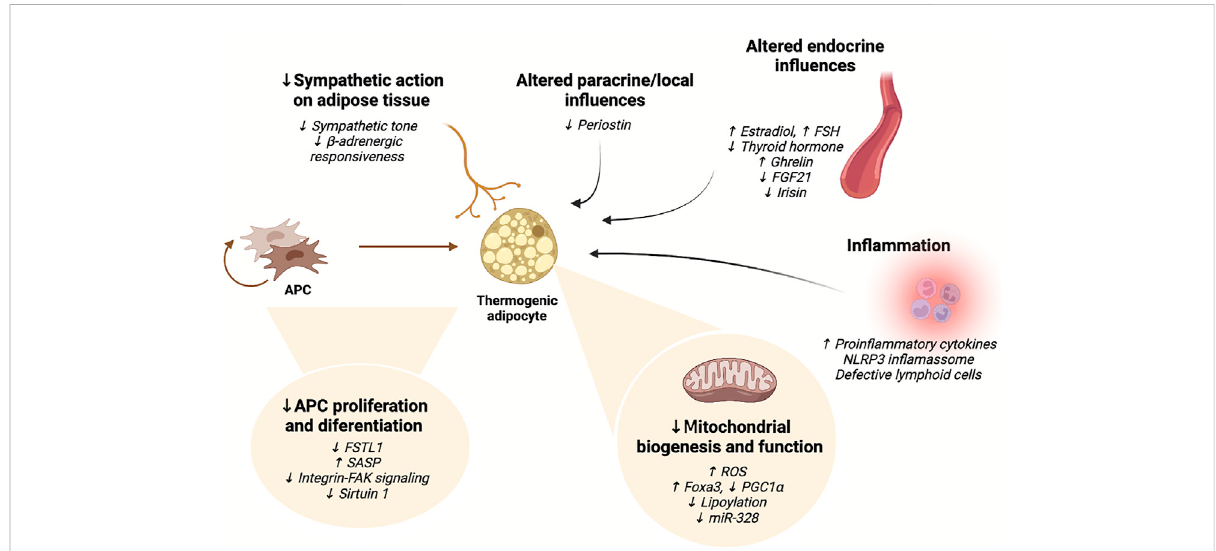
FIGURE 2 Summary of the mechanisms currently implicated in the age-related impairment of thermogenic adipocyte activity. Aging results in impaired ability of thermogenic adipocyte precursor cells to proliferate and differentiate, reduced mitochondrial biogenesis, mitochondrial dysfunction, and diminished sympathetic action. In fl ammatory signaling negatively affects brown and beige adipocyte differentiation and impairs thermogenic activity. Moreover, various endocrine and paracrine in fl uences on adipocytes change with advanced age, also impacting thermogenic adipocytefunction.FAK:focaladhesionkinase;FGF21: fi broblastgrowthfactor21;FSH:follicle-stimulatinghormone;FSTL1:follistatin-likeone;miR: microRNA; NLRP3: NACHT, LRR, and PYD domains-containing protein three; PGC1 α : peroxisome proliferator-activated receptor